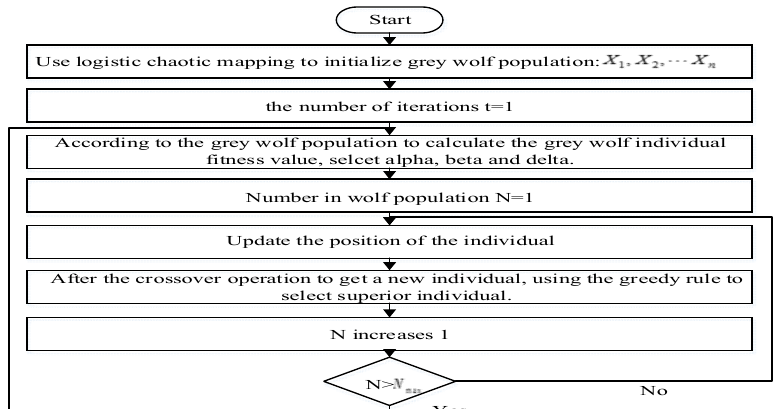
Figure 3. Crossover operation.